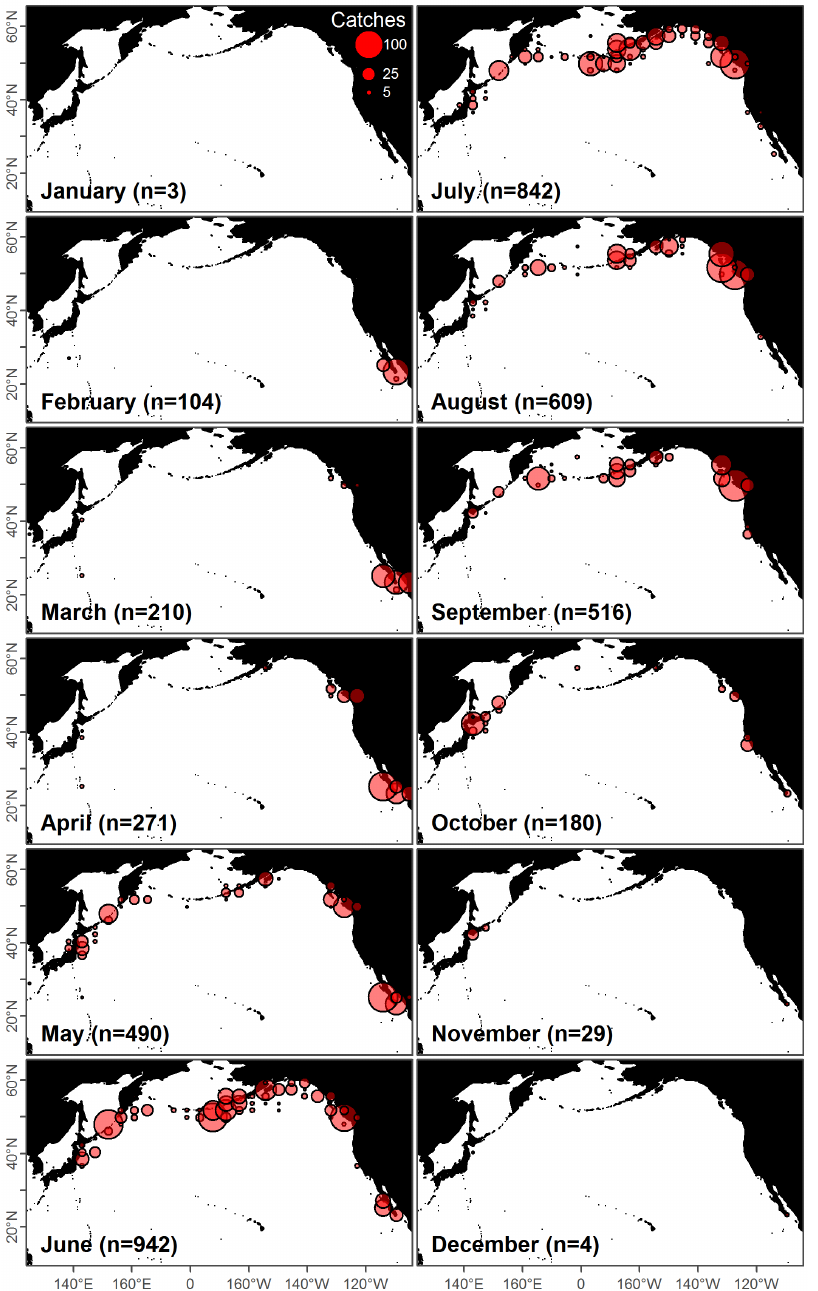
Figure 2. Distribution of the blue whale catches with reported locations. Monthly maps showing blue whale catch locations that were reported without uncertainty ( n ~ 4,200 ; 43% total) to the International Whaling Commission. There are clear spatial and temporal patterns reflecting the migrations of the two populations and whaling seasons.